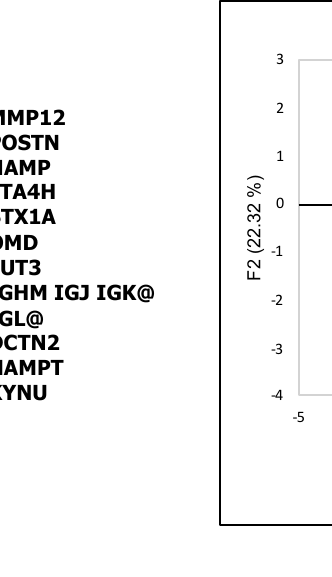
Figure 2. ( A ). Heat map of 25 proteins differentially expressed ( p < 0.01) in the preoperative and postoperative states, as shown by patient. In the colormap, red denotes upregulation and green denotes downregulation. ( B ). Box Whisker plots of the selected top proteins.